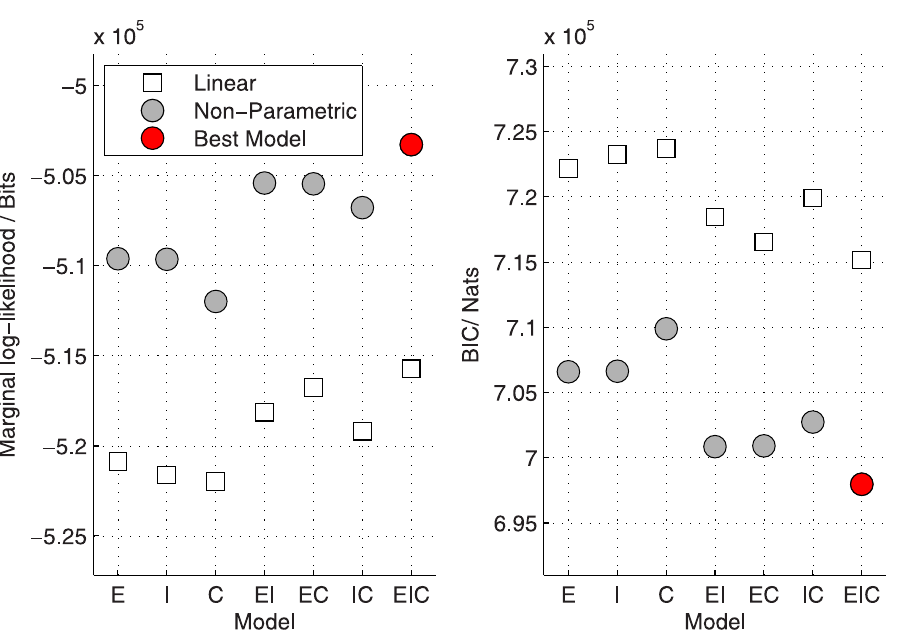
Fig 1. Feature selection and model comparison, showing the marginal log-likelihoods (left panel) and BIC values (right panel) for linear and non-parametric neighbourhood choice models with all possible sets of predictive features. Log-likelihoods are evaluated in base 2 and thus shown in units of bits, while BIC is evaluated in the natural logarithmic base and thus reported in units of nats. This analysis shows that the ethnic composition (E), average income (I), and proportion of households with children (C) in a neighbourhood are all relevant in neighbourhood selection, and that neighbourhood choices are far better predicted by a flexible non-parametric model than a traditional linear